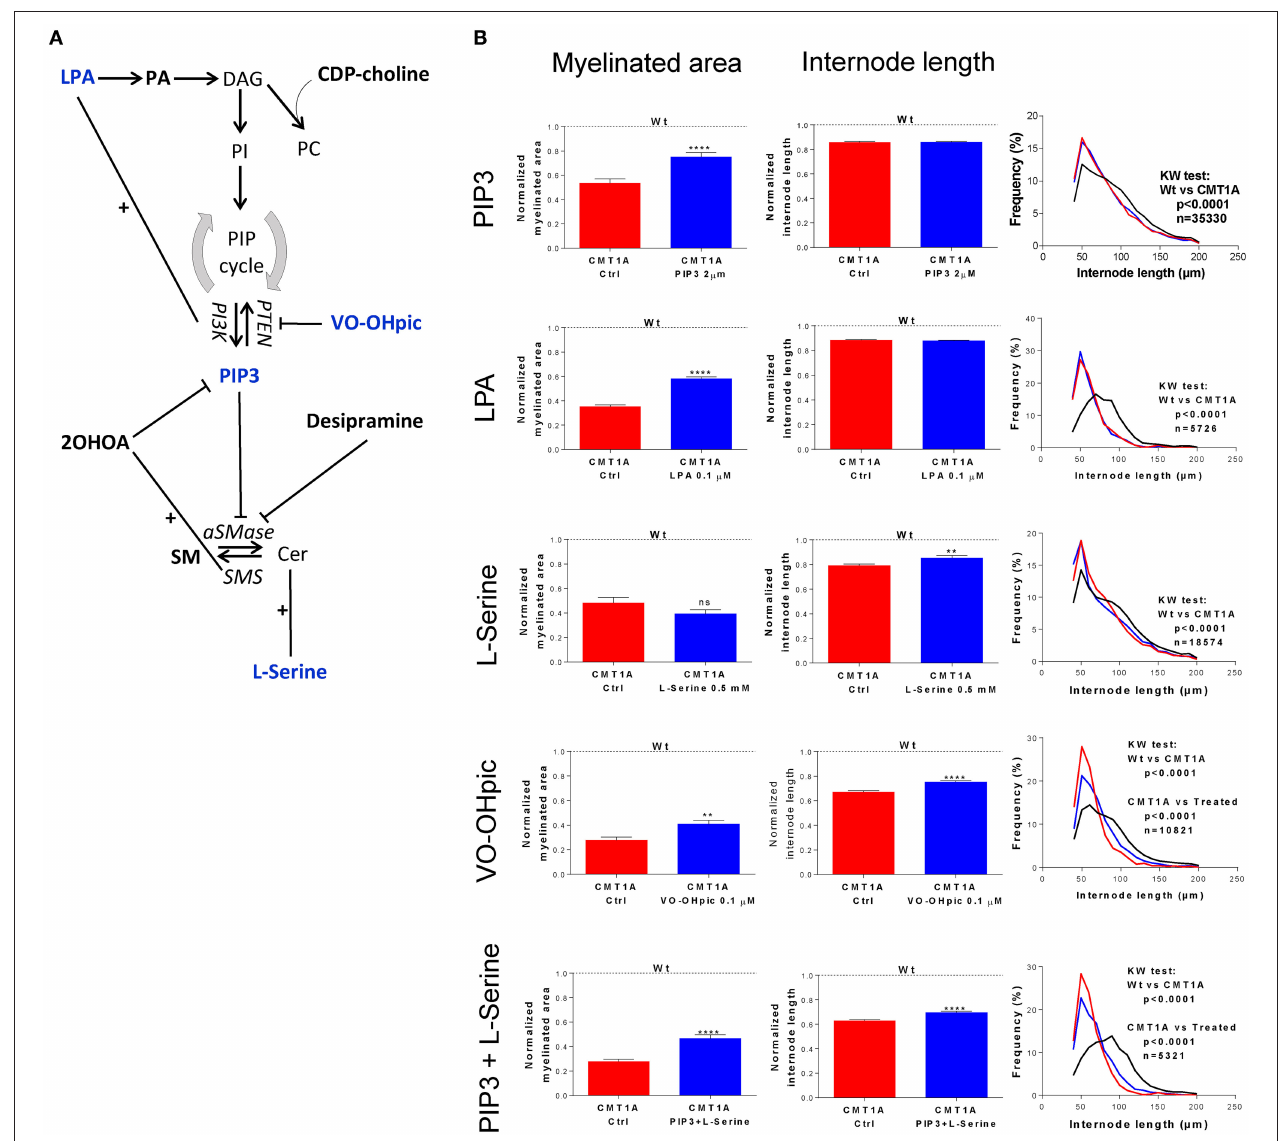
FIGURE 3 | Modulation of sphingolipid (SP) and glycerophospholipid (GP) pathways affects the CMT1A myelin physical structure. (A) Schematic illustration of treatment schedule adopted to demonstrate the specific involvement of SP and GP in CMT1A myelinopathy. The CMT1A and WT DRG cultures were chronically treated with several molecules selected for their proven efficacy on SP and GP pathway modulation in the presence of 15% newborn calf serum, ascorbic acid (100 µ g/ml final concentration), and nerve growth factor at 5ng/ml final concentration. In particular, we analyzed the effects on myelination of LPA, PA, CDP-choline, PIP3, VO-OHpic, 2OHOA, desipramine, SM, and L-serine. (B) Advanced neuropathology (see also the Video S1 ) performed on dorsal root ganglia (DRG) myelinated fibers allowed us to select PIP3, LPA, VO-OHpic, and L-serine as the most effective molecules. Interestingly, we found that these molecules improved the